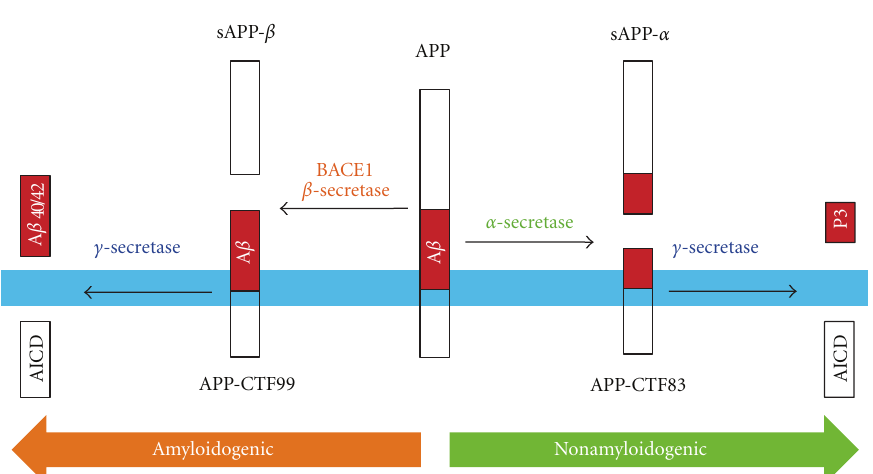
Figure 1: A diagram of amyloid precursor protein (APP) processing pathways. The transmembrane protein APP (membrane indicated in blue) can be processed by two pathways, the nonamyloidogenic α -secretase pathway and the amyloidogenic β -secretase pathway. In the nonamyloidogenic pathway, α -secretase cleaves in the middle of the β -amyloid (A β ) region (red) to release the soluble APP-fragment sAPP- α . The APP C-terminal fragment 83 (APP-CTF83) is then cleaved by γ -secretase to release the APP intracellular domain (AICD) and P3 fragment. In the amyloidogenic pathway, β -secretase cleaves APP to produce the soluble fragment sAPP- β . APP-CTF99 is then cleaved by β γ -secretase to produce A β 40 , A 42 and